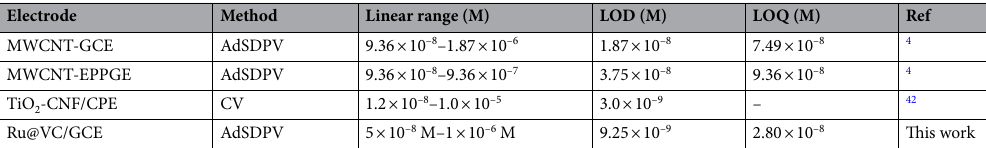
Table 3. Comparison of studies for IDA detection. CNF carbon nanofibers, CPE carbon paste electrode, EPPGE edge plane pyrolytic graphite electrode, MWCNT multiwalled carbon nanotubes, TiO 2 titanium dioxide nanoparticles.